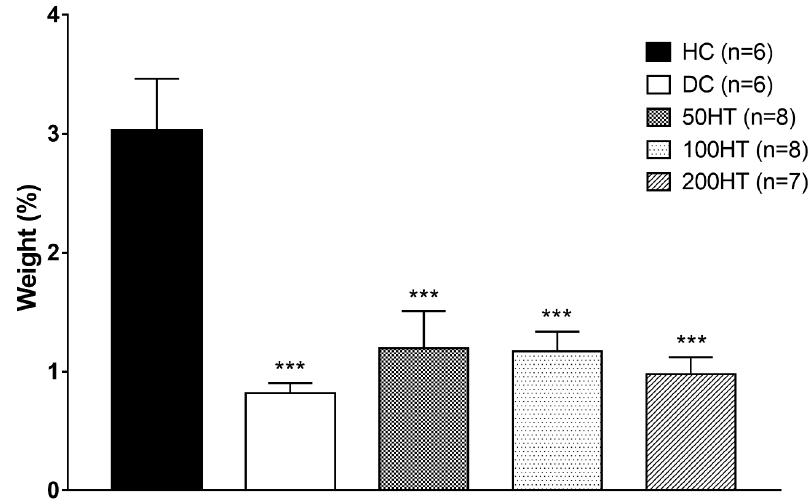
Figure 9. E ff ect of horsetail on adiposity. The *** indicates significant di ff erence from the HC group ( p <